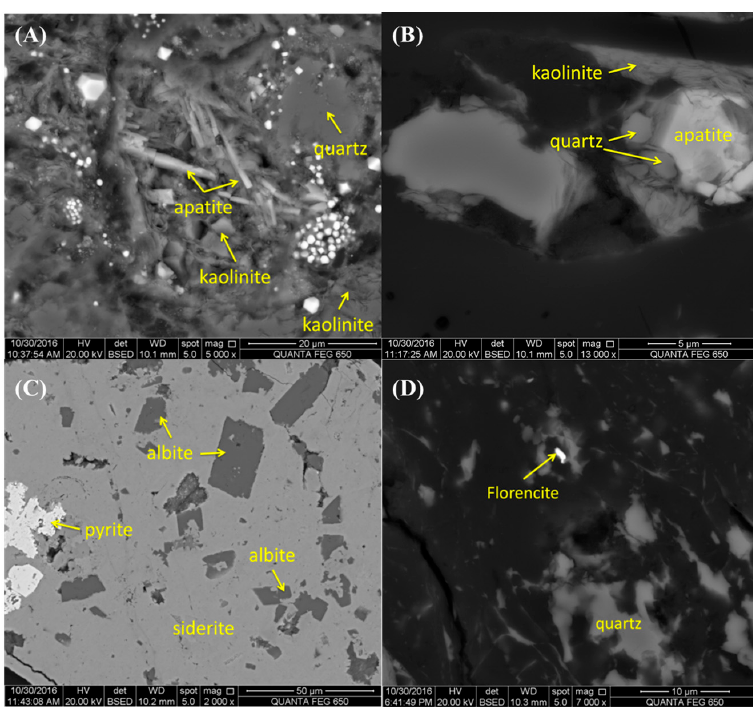
Figure 14. ( A ) Apatite, kaolinite, quartz and pyrite; ( B ) apatite coated by kaolinite; ( C ) albite in siderite matrix; ( D ) florencite (REE-bearing mineral) in organic matter matrix. SEM back-scattering images, ( A – C ) are from SGT1-11 sample; ( D ) is from SGT1-9 sample.